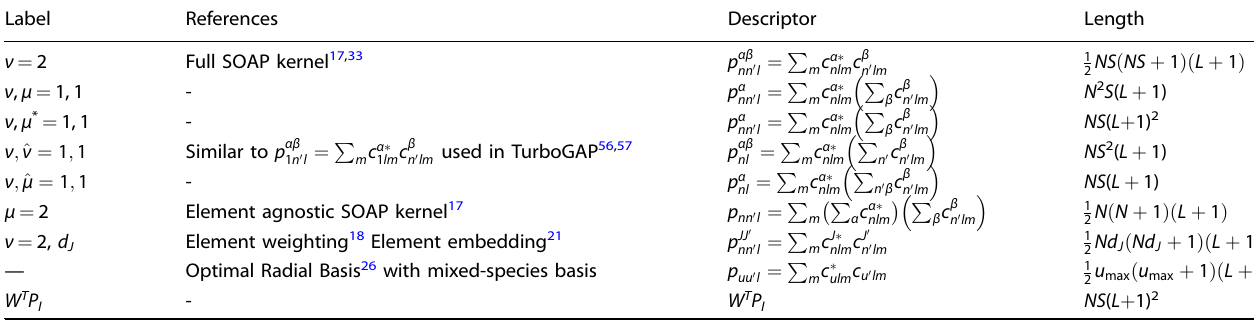
Table 1. Overview of compression schemes.